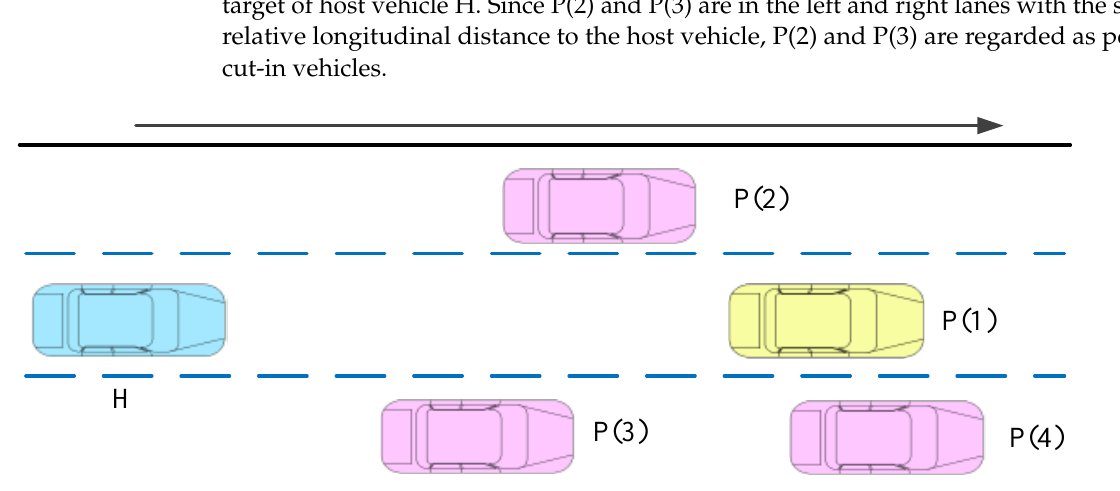
Figure 5. Determination of potential cut-in vehicles.